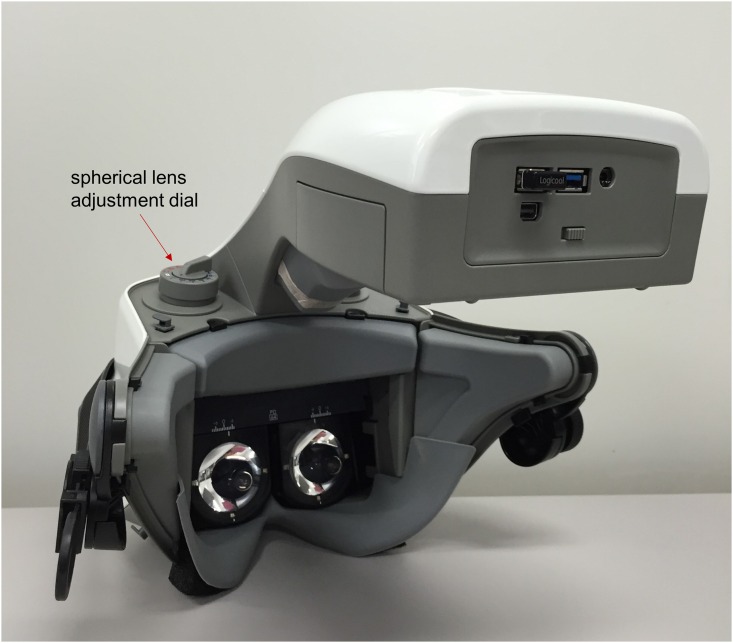
The perimeter unit.The perimeter imo has completely isolated optical systems for the right and left eyes. Stimulus presentation is also independently performed for each eye.